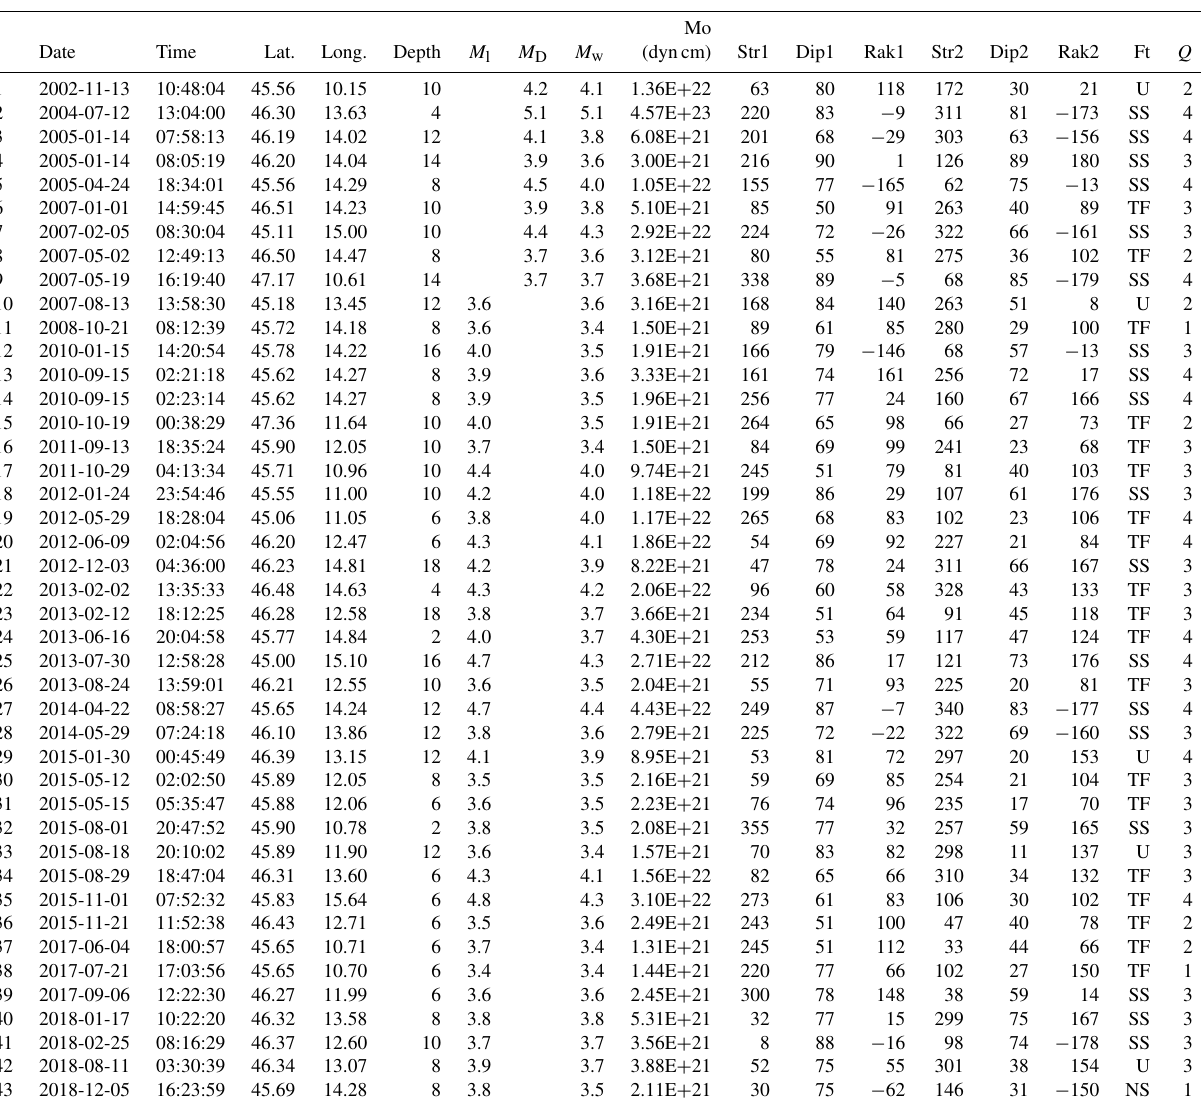
Table 2. Parameters of the new focal mechanism solutions computed by the moment tensor (Saraò, 2020): date (yyyy-mm-dd), time (hh:mm:ss), lat. (latitude north in degrees) and long. (longitude east in degrees), depth (km), M l (local magnitude), M D (duration mag- nitude), M w (moment magnitude), Mo (seismic moment), Str1, Dip1, and Rak1 (strike, dip, and rake of the first fault plane in degrees), Str2, Dip2, and Rak2 (strike, dip, and rake of the second fault plane in degrees), Ft (fault type according to Zoback 1992), and Q (quality inversion parameter; 4 is the best solution). Other details are given in the full catalogue (Supplement and Saraò et al.,